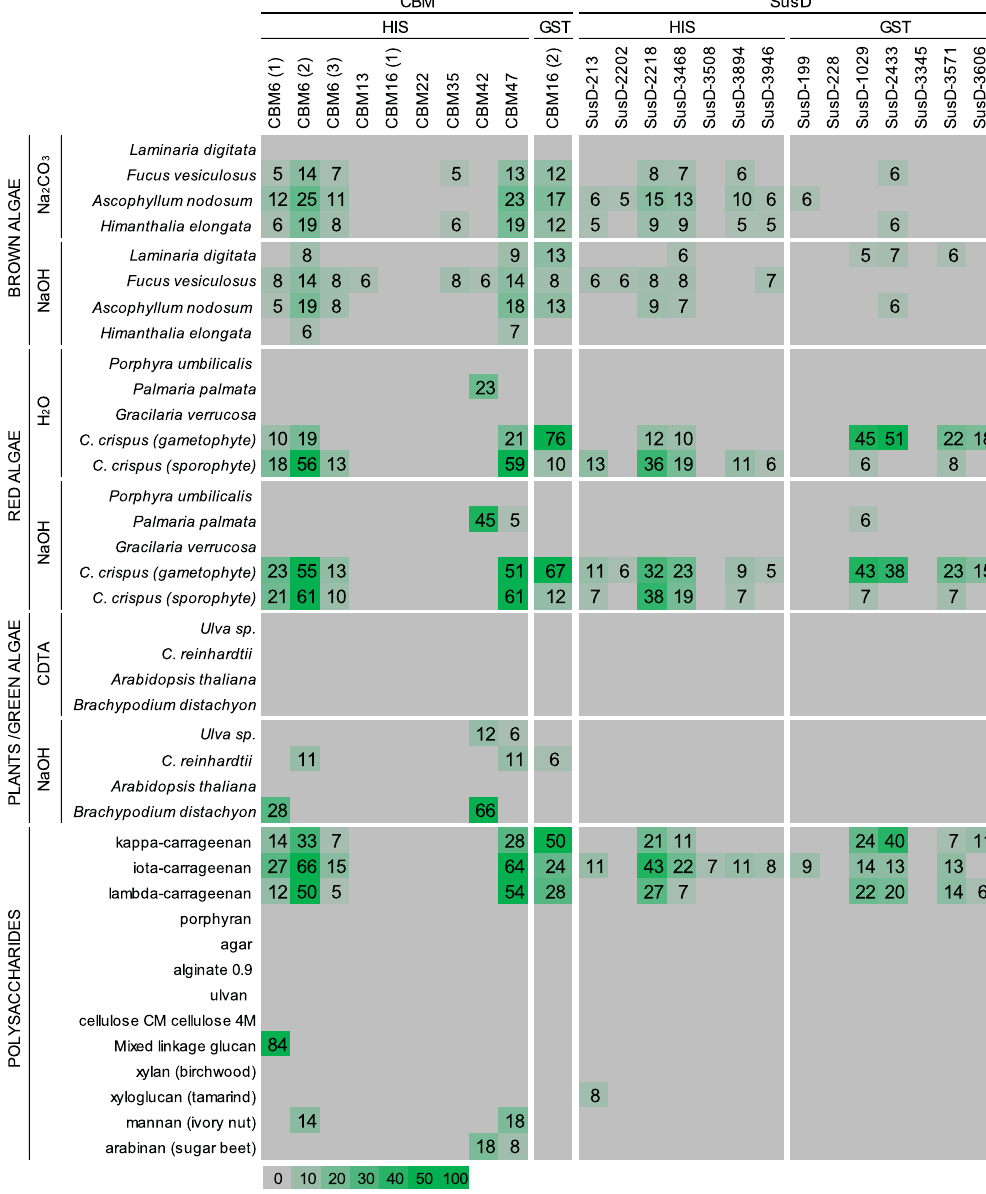
Figure 3. DB-CoMPP analysis of marine samples. CoMPP binding profiles of the supernatants of bacterial lysates towards a range of cell wall extracts and commercial polysaccharides. Results are means of three individual experimental replicates. The colour scale in relation to absorbance values is shown. The highest mean signal value in the entire data set was set to 100 and all other signals adjusted accordingly. Values < 5 were considered as background and